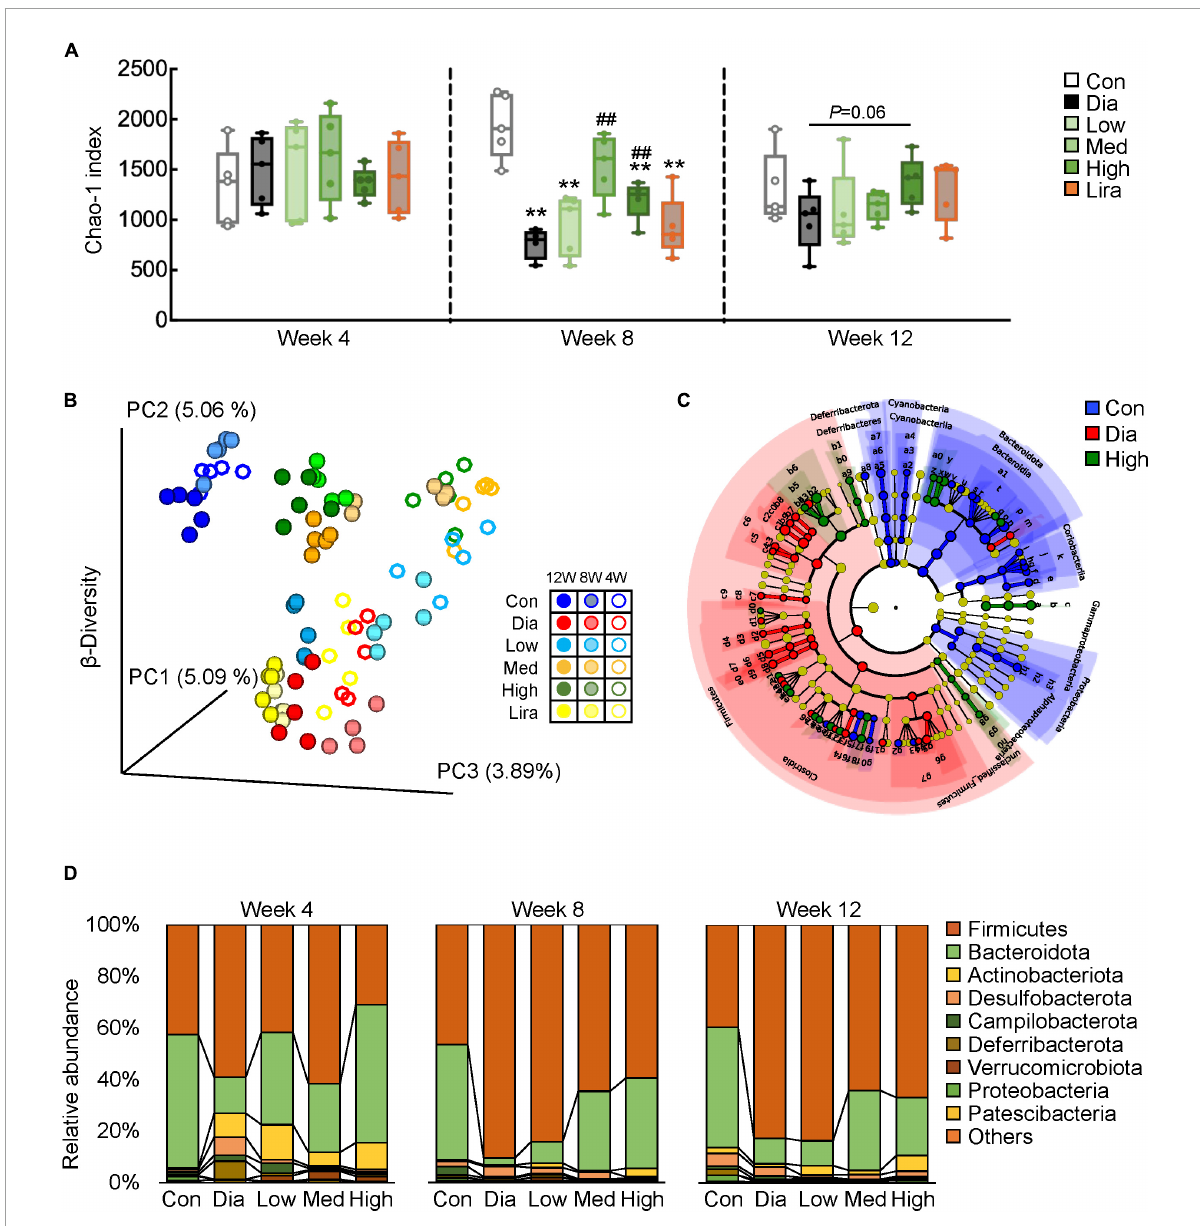
FIGURE5 CFP administration remodels the composition of gut microbiota. (A) α -Diversity of the gut microbial communities in the feces after 4, 8, and 12 weeks of treatment. Data are presented as the means ± SEM, * P < 0.05, ** P < 0.01 vs. control; # P < 0.05, ## P < 0.01 vs. Dia. (B) β -Diversity of the gut microbial communities in the feces. (C) Cladogram generated from LEfSe analysis between the control, diabetic, and high-dose CFP-treated mice. (D) Relative abundance of microbiota at the phylum